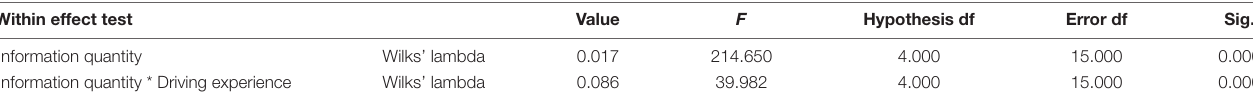
TABLE 13 | The information amount factor main effect and interaction effect of the experience factor.